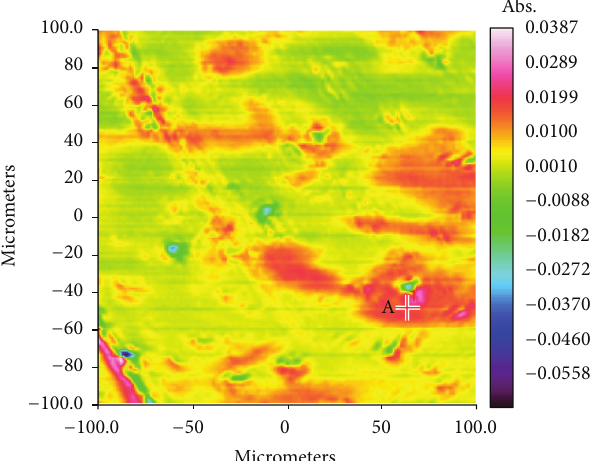
Figure 5: Intensity distribution map of UHMWPE/R-PA6/HDPE- g-MAH sample with 40 wt% R-PA6.